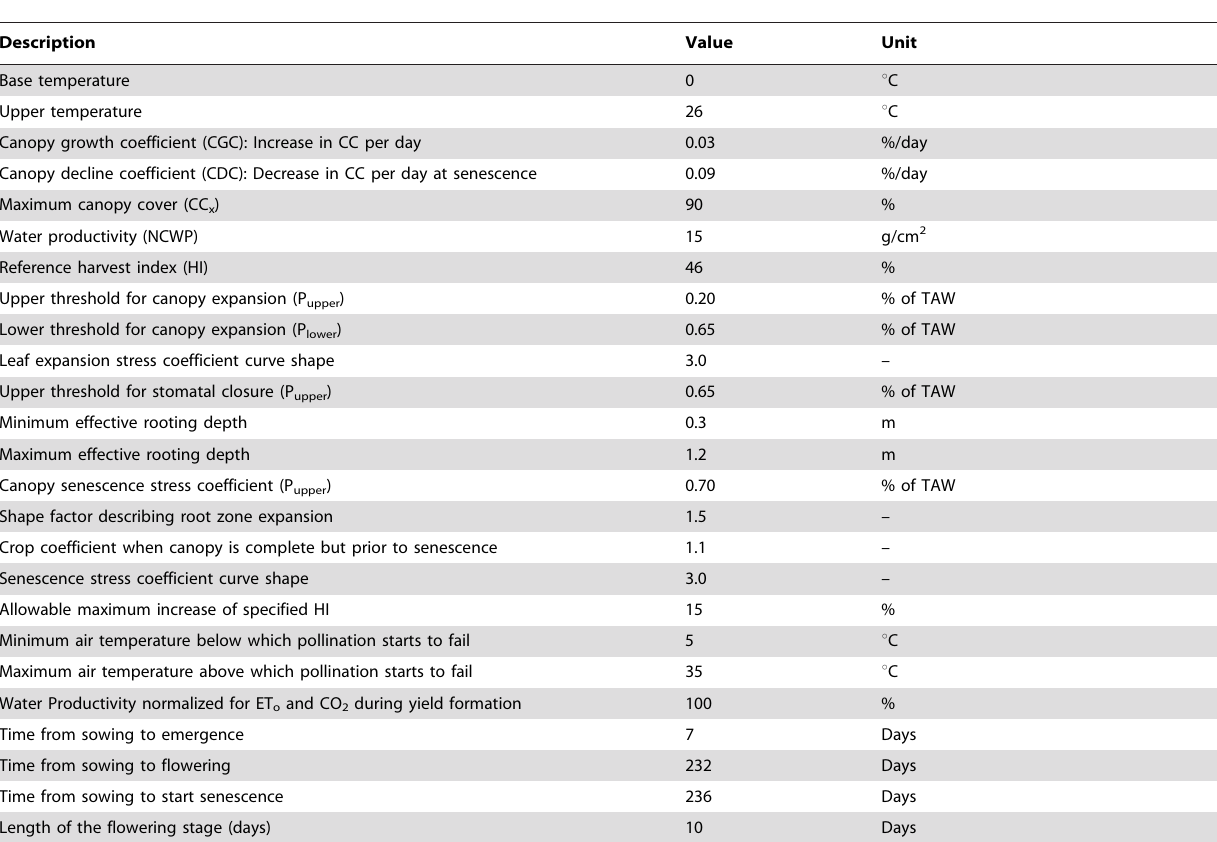
Table 4. Input data of crop parameters used in AquaCrop